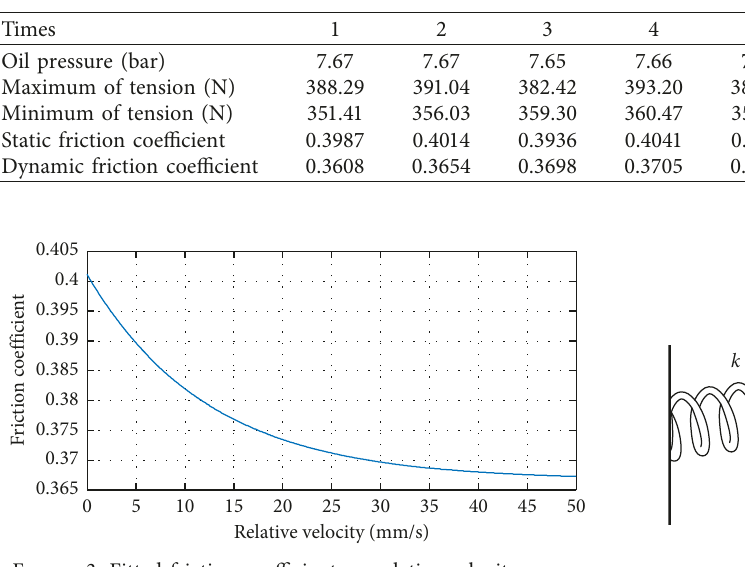
Figure 3: Fitted friction coefficient vs. relative velocity curve.